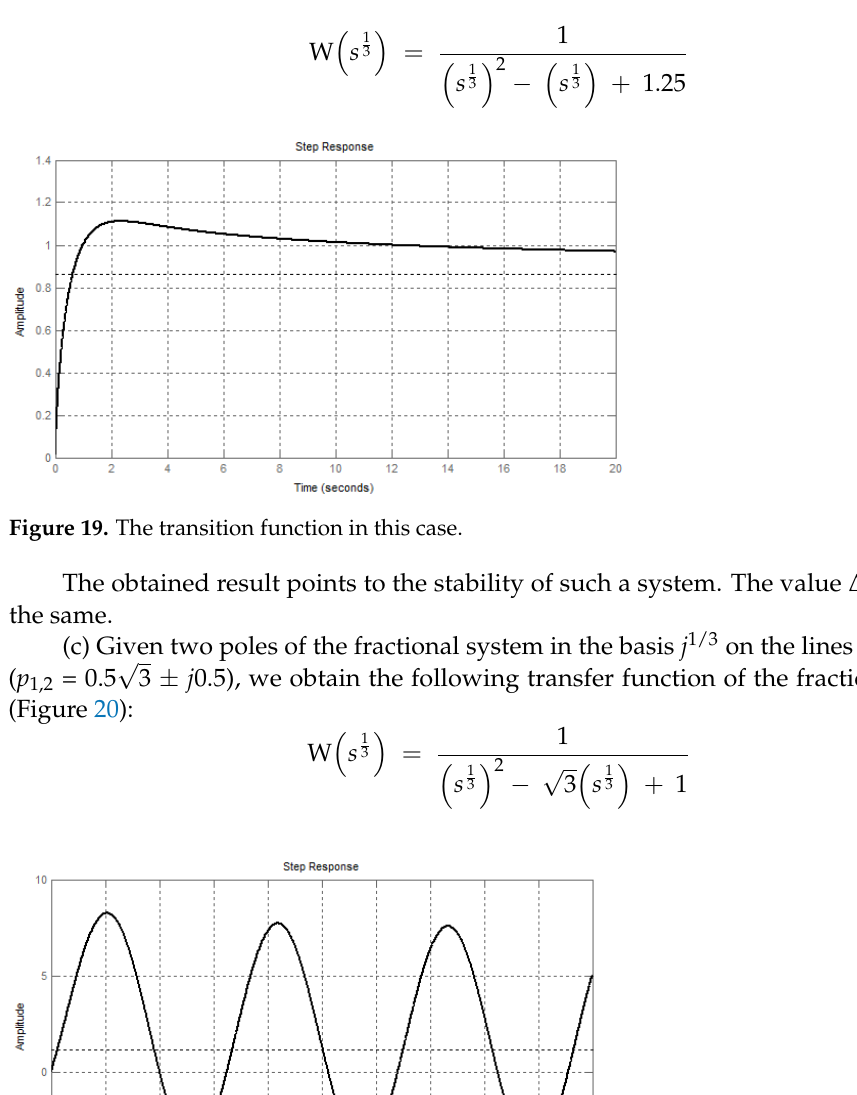
Figure 18. The transition function in this case.